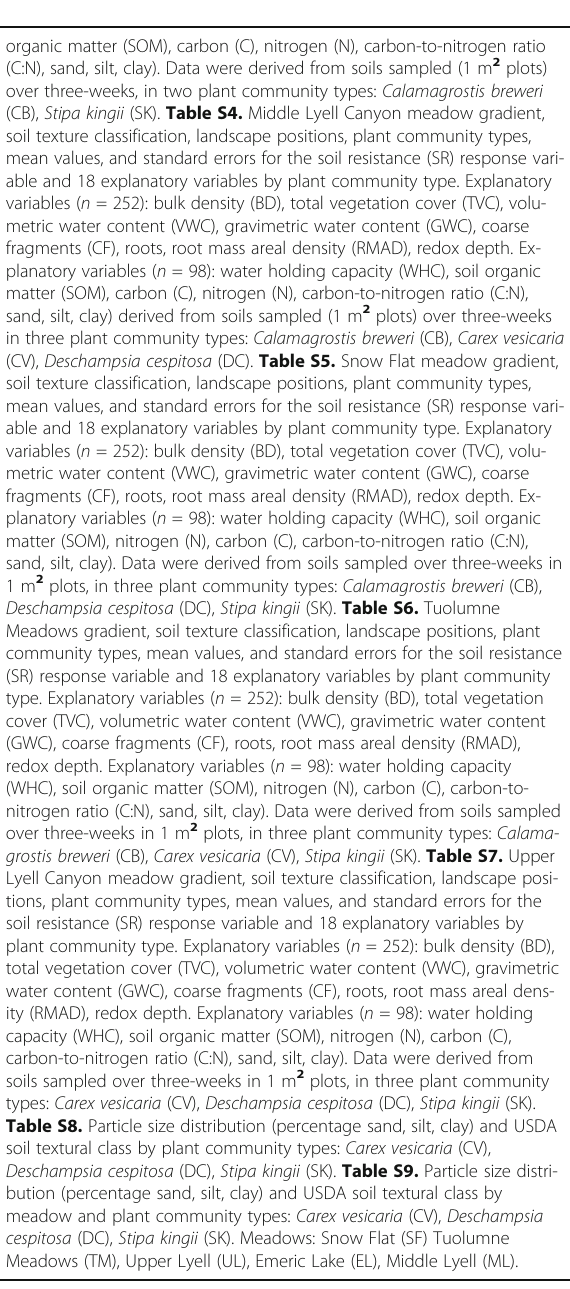
Additional file 1: Table S1. Mean values ± standard errors and p- values for the soil resistance (SR) response variable and eight explanatory variables that significantly differed ( p <0.05) by plant community type. Ex- planatory variables ( n = 252): bulk density (BD), gravimetric water content (GWC), volumetric water content (VWC), total vegetation cover (TVC 1 m 2 ), TVC 700 cm 2 . Explanatory variables ( n = 98): water holding capacity (WHC), nitrogen (N) Data were derived from soils sampled over a three- week period in subalpine meadows ( n = 5) at Yosemite National Park, USA. Soils were sampled within two different plot sizes (1 m 2 and 700 cm 2 ), in four different plant community types: Calamagrostis breweri (CB), Carex vesicaria (CV), Deschampsia cespitosa (DC), Stipa kingii (SK). Table S2. Mean values, standard errors, and p -values for the soil resistance (SR) response variable and 10 explanatory variables that significantly differed ( p <0.05) by meadow gradient class. Explanatory variables ( n = 252): gravi- metric water content (GWC), volumetric water content (VWC), and coarse fragments (CF). Explnatory variables ( n = 98): water holding capacity (WHC), soil organic matter (SOM), nitrogen (N), sand, silt, clay). Data were derived from soils sampled over a three-week period. Soils were sampled in a total of 5 subalpine meadows representing two meadow gradient classes: Low (<2% slope) and Middle (2 – 4% slope) at Yosemite National Park, USA: Snow Flat (SF) Tuolumne Meadows (TM), Upper Lyell (UL), Emeric Lake (EL), Middle Lyell (ML). Table S3. Emeric Lake meadow gra- dient, soil texture classification, landscape positions, plant community types, mean values, and standard errors for the soil resistance (SR) re- sponse variable and 18 explanatory variables by plant community type. Explanatory variables ( n = 252): bulk density (BD), total vegetation cover (TVC), volumetric water content (VWC), gravimetric water content (GWC), coarse fragments (CF), roots, root mass areal density (RMAD), redox depth. Explanatory variables ( n = 98): water holding capacity (WHC), soil